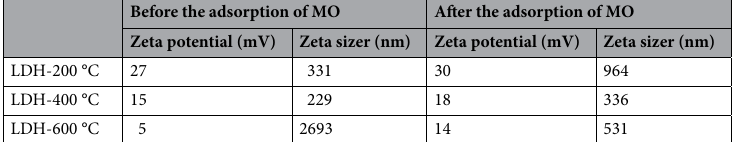
Table 1. The crystallite size of the prepared LDH and LDH/MO samples.